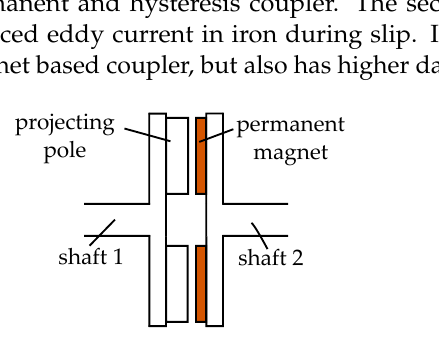
Figure 15. Sectional view of a variable reluctance